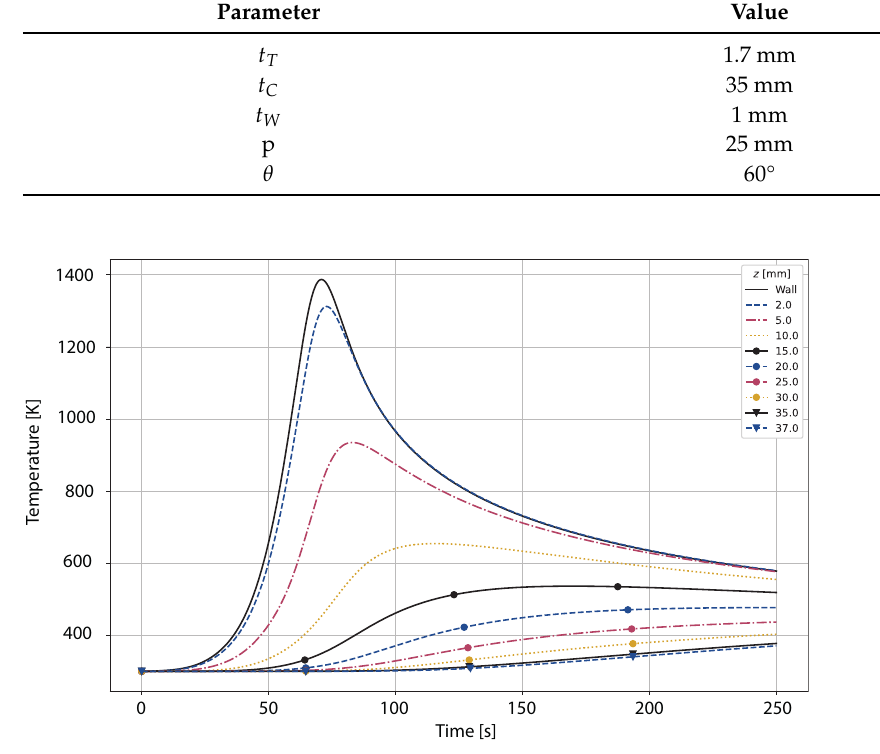
Figure 11. Temperature evolution at different points in the out-of-plane direction (z) for the optimised CMC-based corrugated core